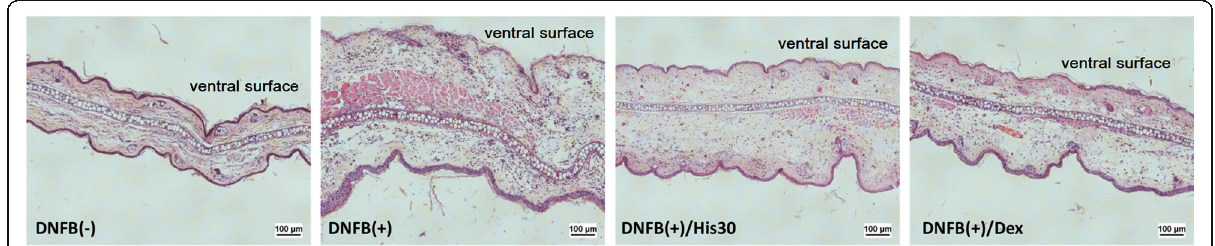
Fig. 2 Representative photomicrographs of DNFB-sensitized mouse pinna after hispidulin treatment. Transverse sections of murine ears with no sensitization [DNFB ( − )], DNFB sensitization [DNFB (+)], and DNFB sensitization together with treatment of 30 μ g/ear hispidulin (His30) or 30 μ g/ear dexamethasone (Dex) were compared at 24-h post-challenge. All tissues were stained with hematoxylin and eosin (H &